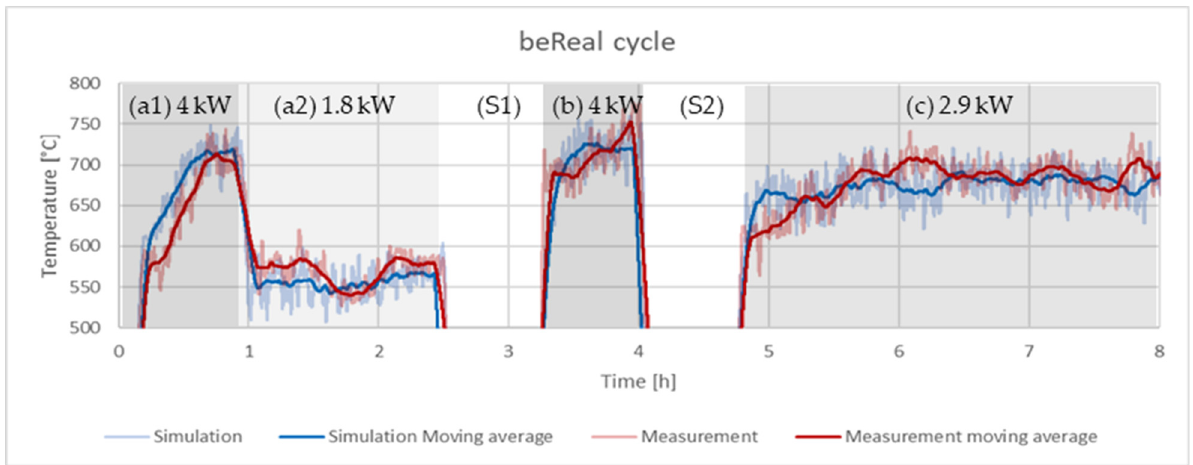
Figure 14. Comparison of the temperature development in the main combustion chamber according to a load cycle test performed (red) and a simulation (blue). to a load cycle test performed (red) and a simulation (blue).